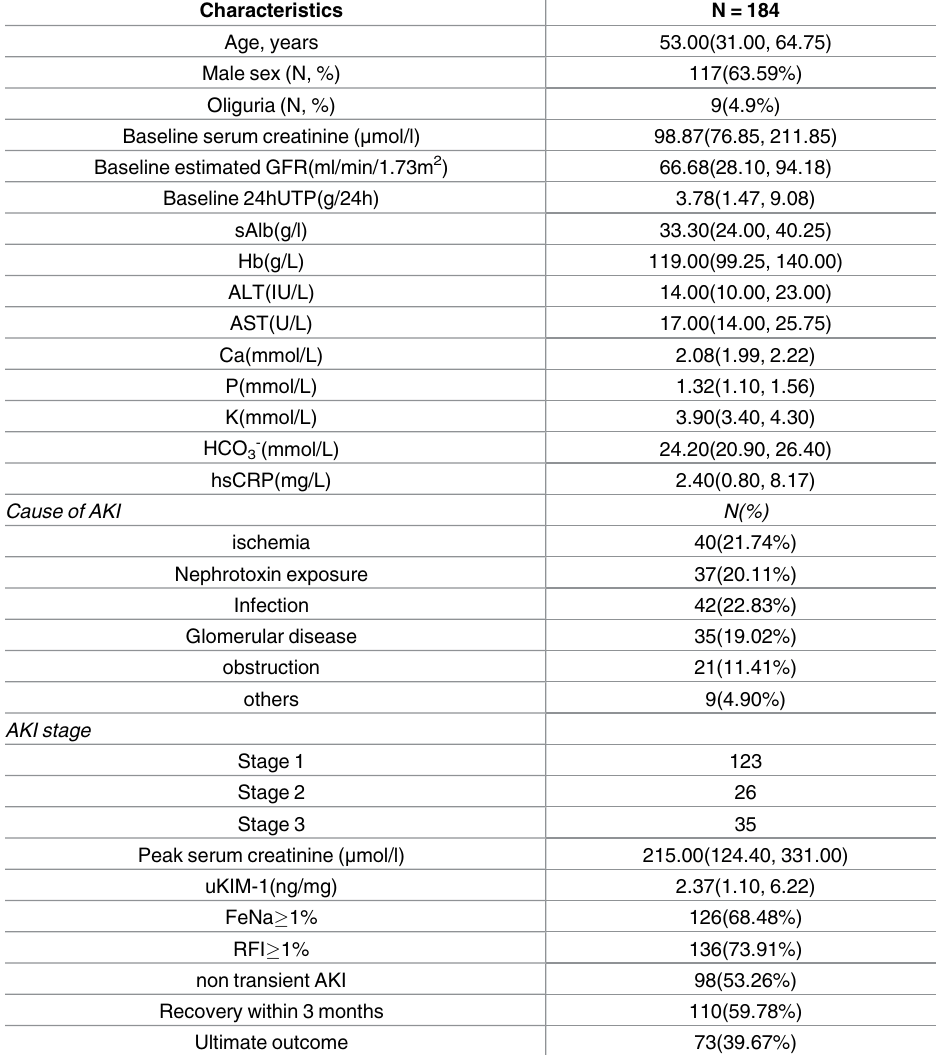
Table 1. General condition of